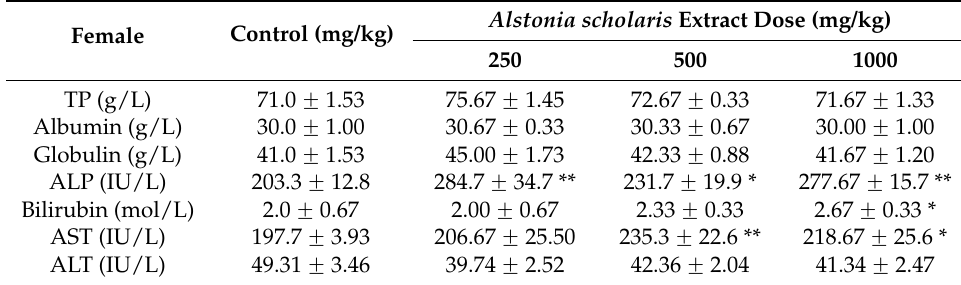
Table 5. Biochemical parameters in the serum of female rats orally treated with the methanolic extract of the bark of Alstonia scholaris . Results were expressed as the mean ˘ S.E.M. of 5 rats.